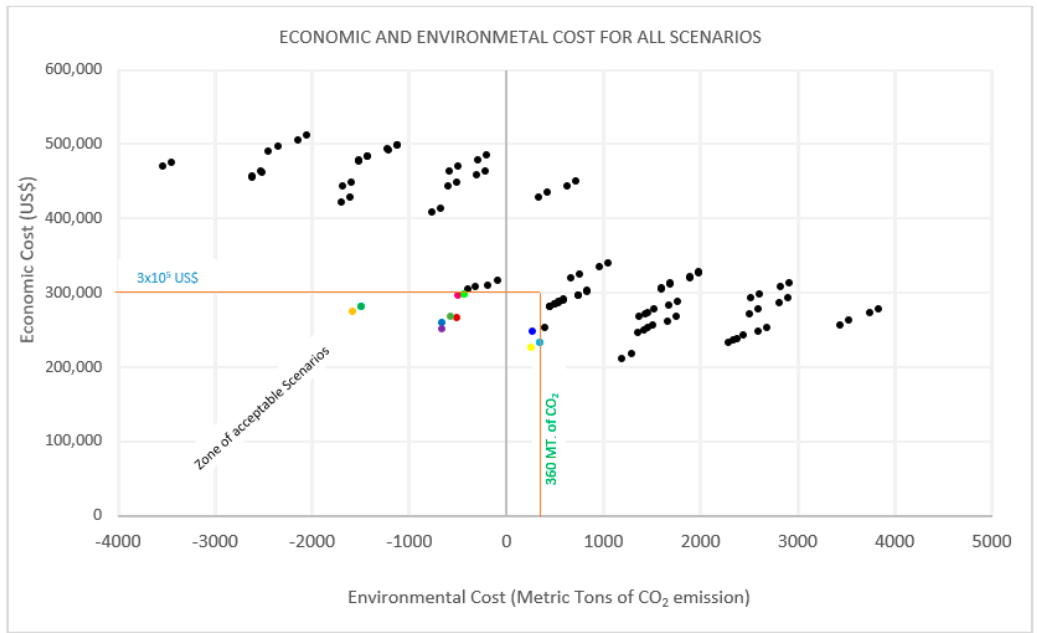
Figure 3. Graphical representation of economic and environmental costs for all scenarios.